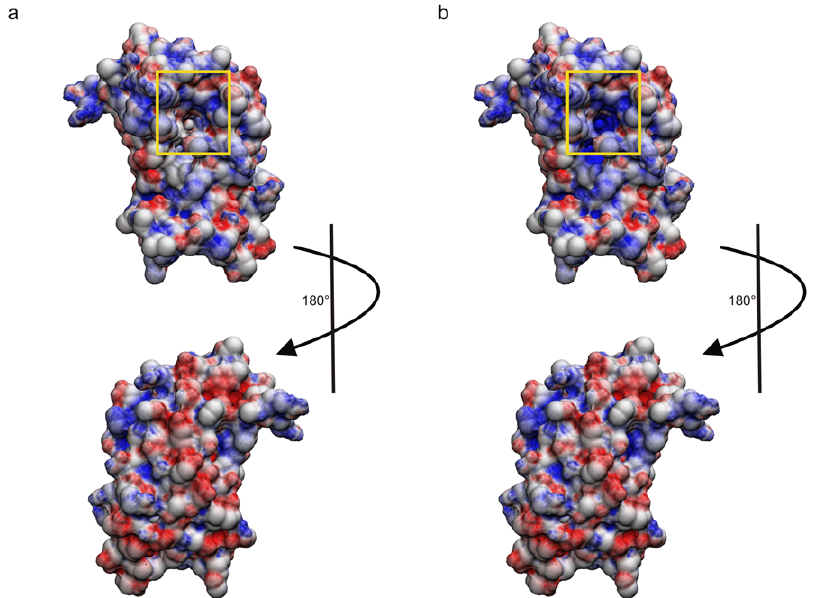
Figure 5. Electrostatic surface potential of the Ber e 1 in absence and presence of Cu 2 + . a) Electrostatic surface potential of the Ber e 1 at pH 7 in absence of Cu 2 + . b) Electrostatic surface potential of the Ber e 1 at pH 7 in presence of Cu 2 + . The entry of the hydrophobic cavity is highlighted with a yellow square. The protein shows an overall positive charge on the side of the protein that comprises the hypervariable loop and the entry to the hydrophobic cavity. In contrast, the other side of the protein, in particular helix 1a and most of helix 1b and 2, is negatively charged. The presence of histidines, taken together with the slow dynamics and the overall negative charge between helix 1b and 2, suggests that Cu 2 + would enter the molecule from the negatively charged side of the protein. However, binding of Cu 2 + only to a small degree changed the net surface charge on the helix 1b-2 side of the protein. The largest difference in surface potential is observed within the hydrophobic cavity; tuning the surface potential inside the cavity from neutral to more positive